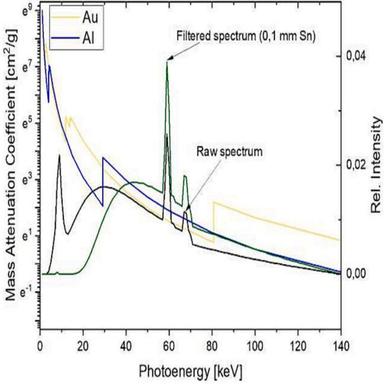
Theoretical mass attenuation coefficient (μ/ρ) for two bond materials gold and aluminum in dependence of the photon energy. In addition, 2 Monte Carlo simulated spectra (raw and 0.1 mm Sn prefilter) for Wolfram target at accelerating voltage 140 kV.